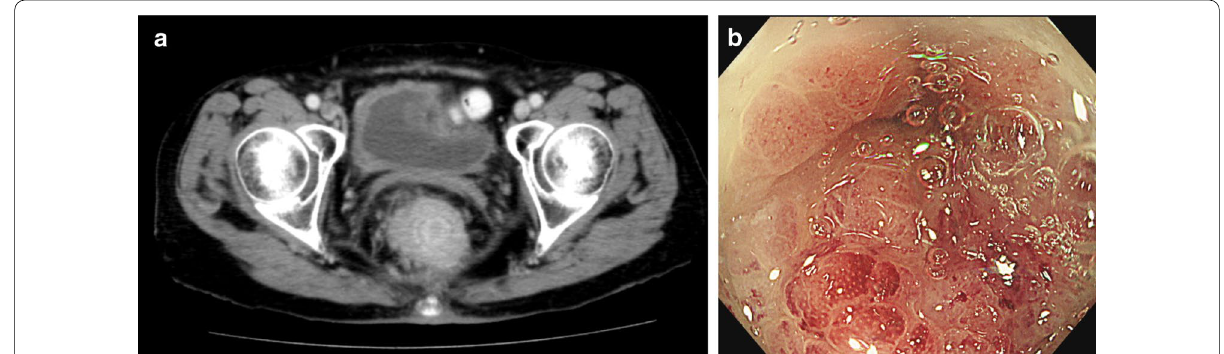
Fig. 1 a Colonoscopy demonstrated an obstructive tumor in the rectum. b CT showed advanced rectal stenosis. CT, computed